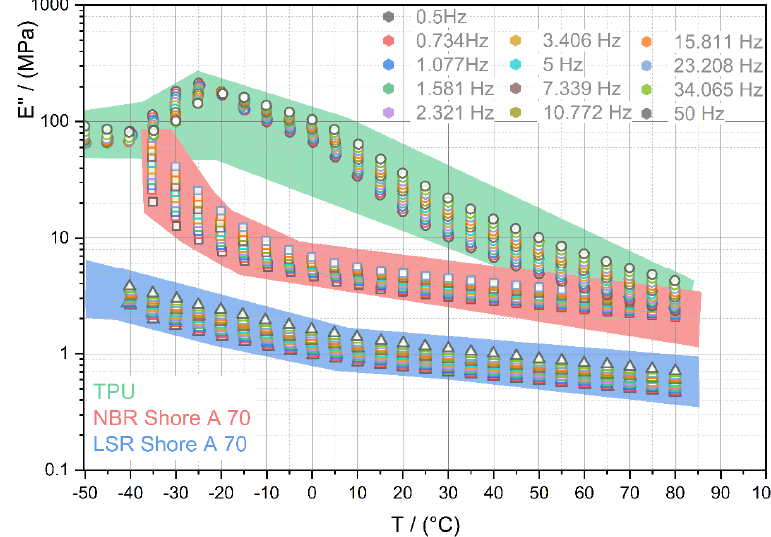
Figure 24. Temperature and frequency dependent loss modulus E” of the candidate materials TPU, NBR and LSR.